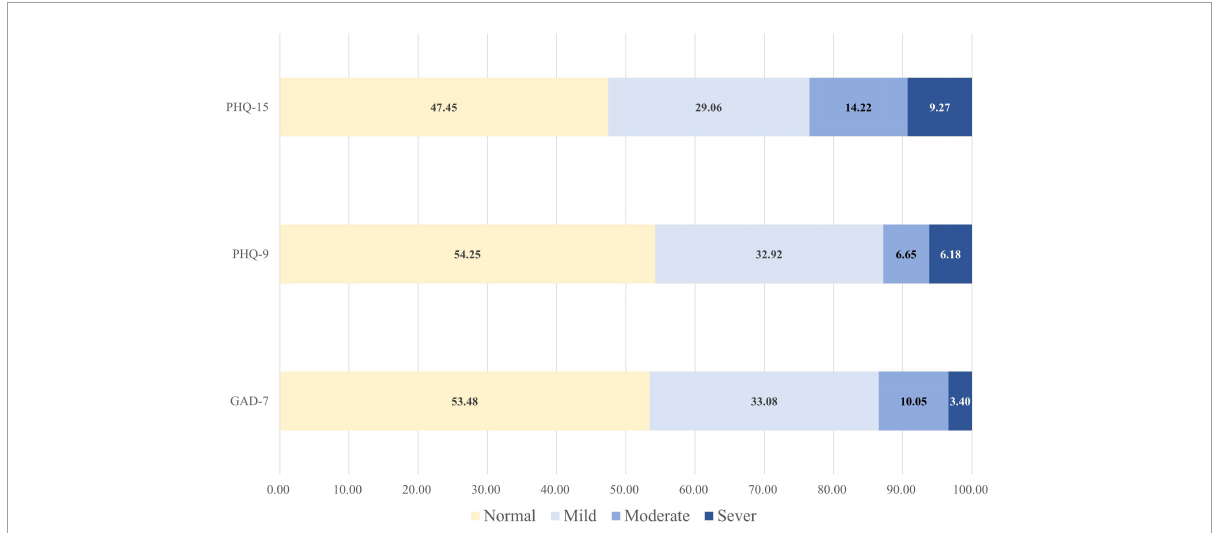
FIGURE1 The prevalence of anxiety, depression, and somatic disorders of medical staff fighting against COVID-19 based on different scales. GAD-7, generalized Anxiety Disorder 7-Item Scale; PHQ-9, Patient Health Questionnaire-9; PHQ-15, Patient Health Questionnaire-15.